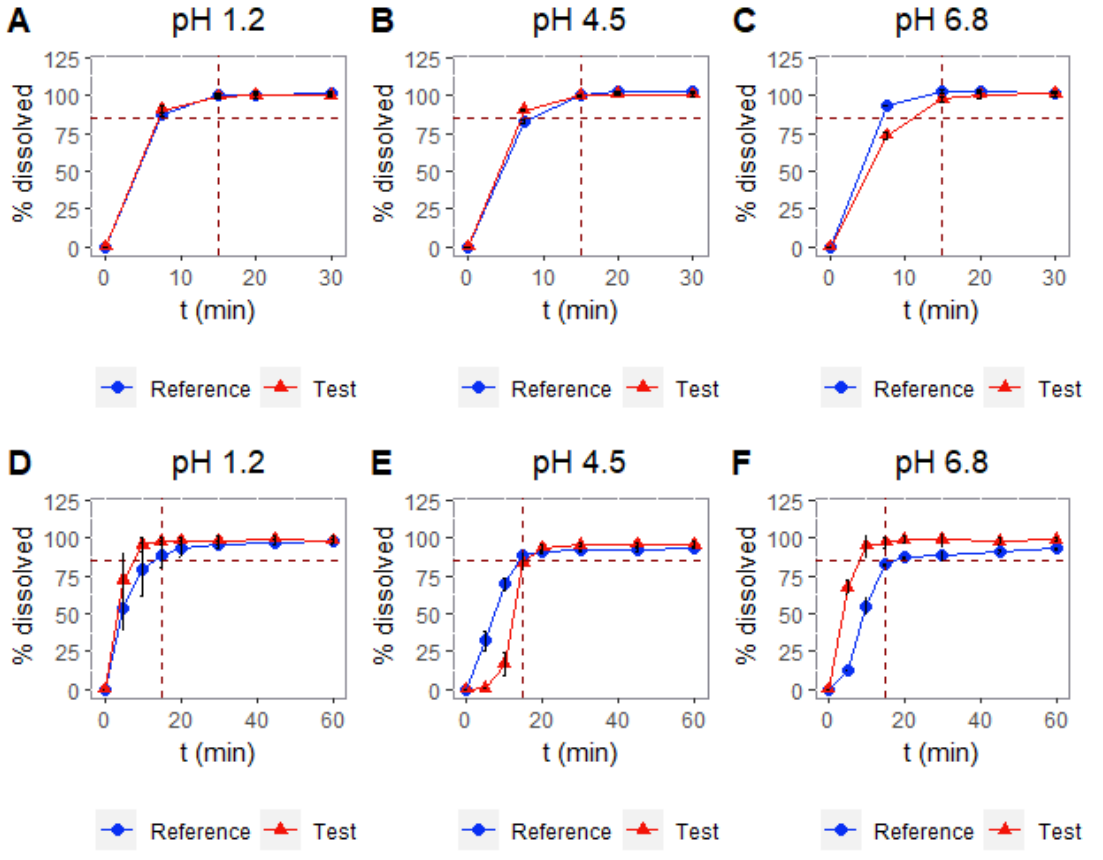
Figure 4. Dissolution profiles for test and reference products at pH 1.2, 4.5, and 6.8. Baskets at